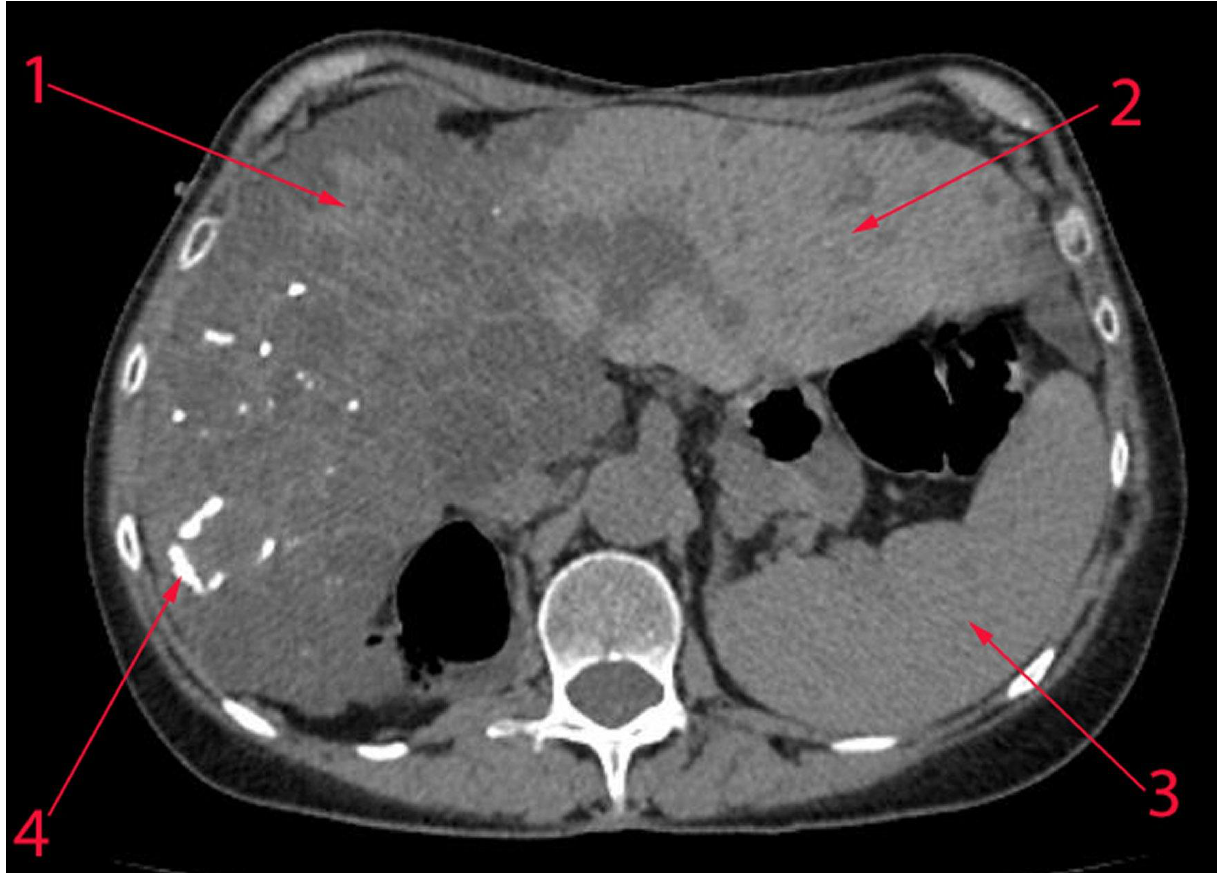
Figure 1 : Abdominal CT. 1: right lobe of the liver with multiple cysts, 2: left lobe of the liver, 3: spleen, 4: calcification of the